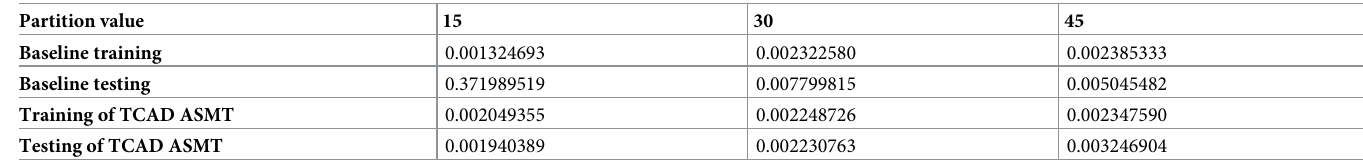
Table 3. MSE values of the training and testing of the 2-input dataset for the TCAD-labeled ASMT algorithm. Partition